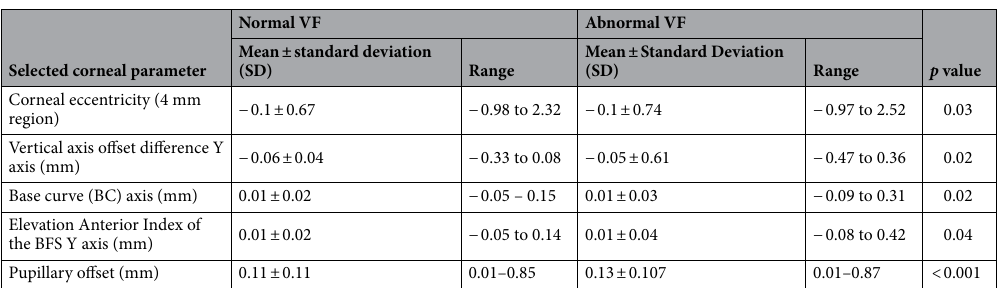
Table 5. Corneal characteristics analysis by VF impairment class allocation. Values are presented as mean ± standard deviation.